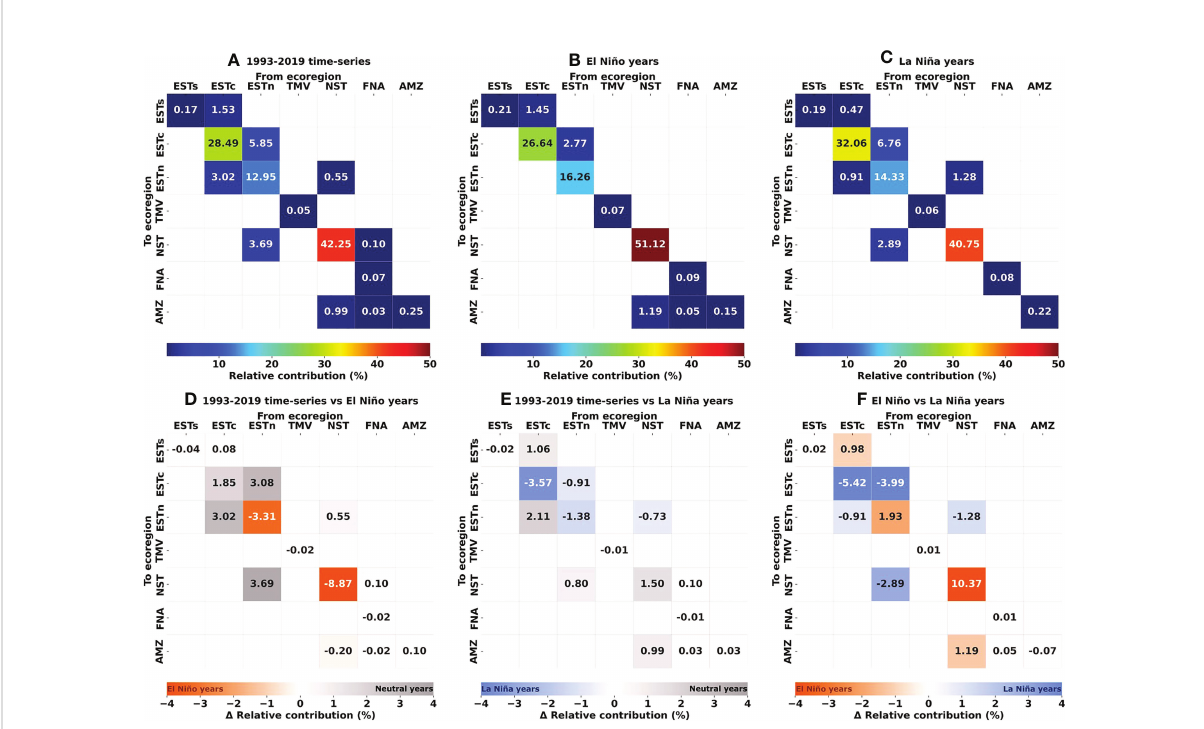
FIGURE 7 Connectivity and delta matrices showing the relative contribution (%) of source and destination ecoregions in larval dispersal, i.e, weighted number of reef sites connections per probability. (A) 1993 – 2019 time-series; (B) El Niño years (1997 – 1998 and 2015 – 2016); (C) La Niña years (1998 – 1999 and 2010 – 2011); (D) 1993 – 2019 time-series minus El Niño years; (E) 1993 – 2019 time-series minus La Niña years; (F) El Niño minus La Niña years. In (D – F) , gray/blue/orange values indicate higher contribution during Neutral/El Niño/La Niña years, respectively. Ecoregions: Eastern-south (ESTs); Eastern-center (ESTc); Eastern-north (ESTn); Northeastern (NST), Amazon (AMZ), Fernando de Noronha-Atol das Rocas (FNA), Trindade-Martim Vaz Islands